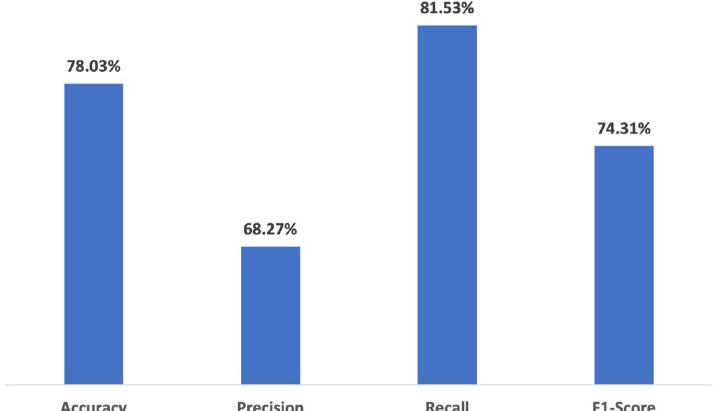
Fig. 9 The SVM results for detecting replay attacks